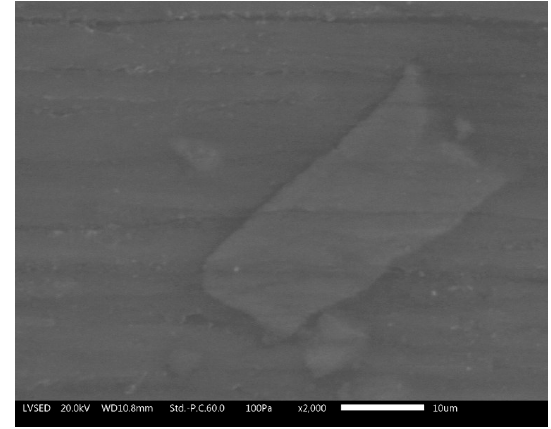
Figure 15. SEM micrograph of a fGO flake on g ‐ 0.2 surface after the 1000 cycles of scrub test.